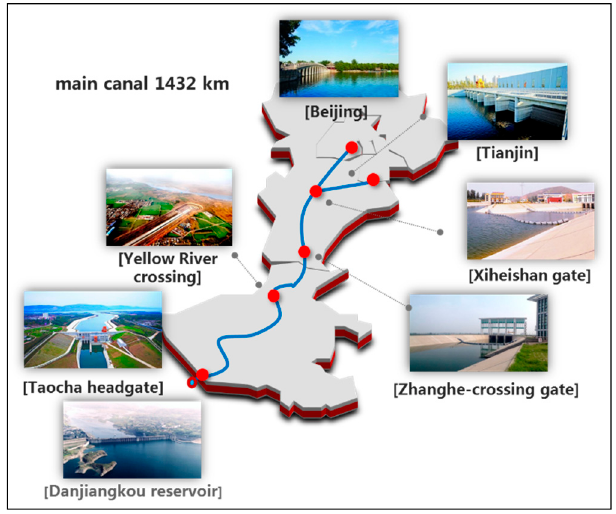
Figure 1. Route map of the Middle Route of South-to-North Water Diversion Project